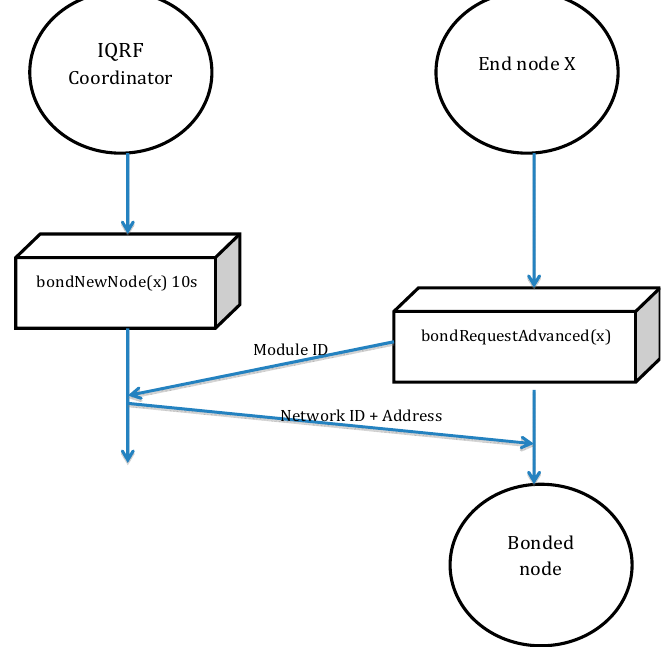
Figure 4. Bonding diagram of the IQRF end nodes to the coordinator.